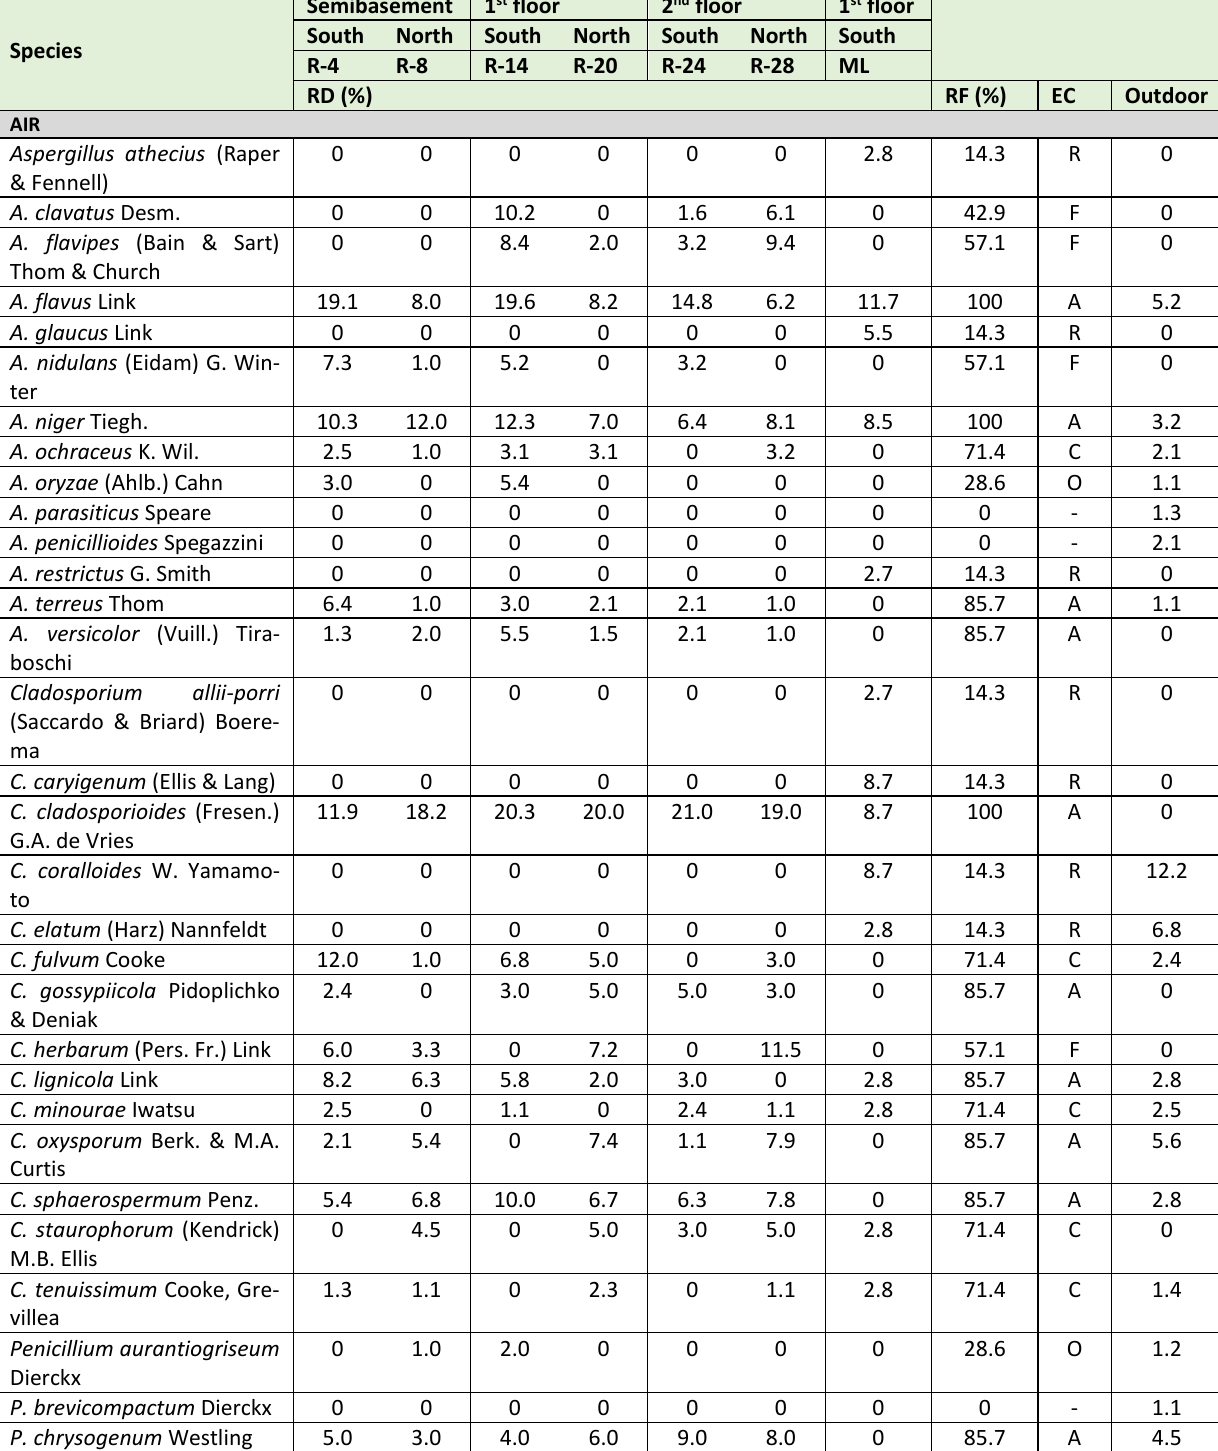
RF: Relative frequency. EC: Ecological categories [30] are Abundant taxa (A) when RF = 100 - 81%, Common taxa (C) when RF = 80 - 61%, Frequent taxa (F) when RF = 60 - 41%, Occasional taxa (O) when RF = 40 - 21% and Rare taxa (R) when RF = 20 - 0.1%. *: Indicates the ex- istence of different percentages of teleomorphs